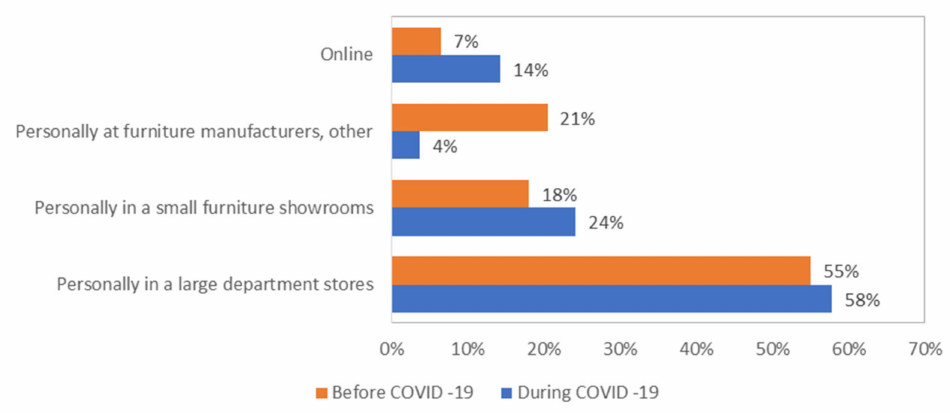
Figure 10. Comparison of the locations for purchasing furniture before ( N = 400) and during the COVID-19 time ( N =